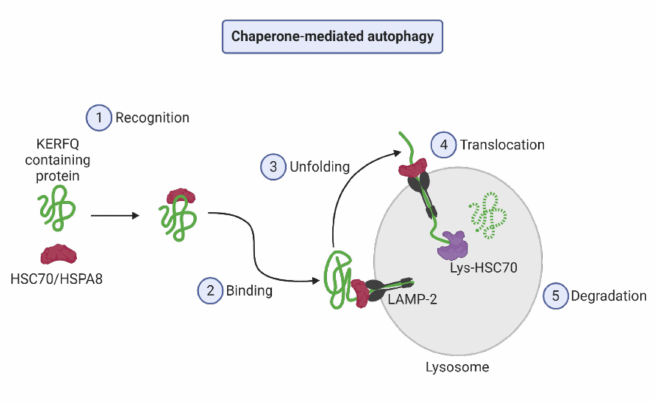
Figure 1. Steps of chaperone-mediated